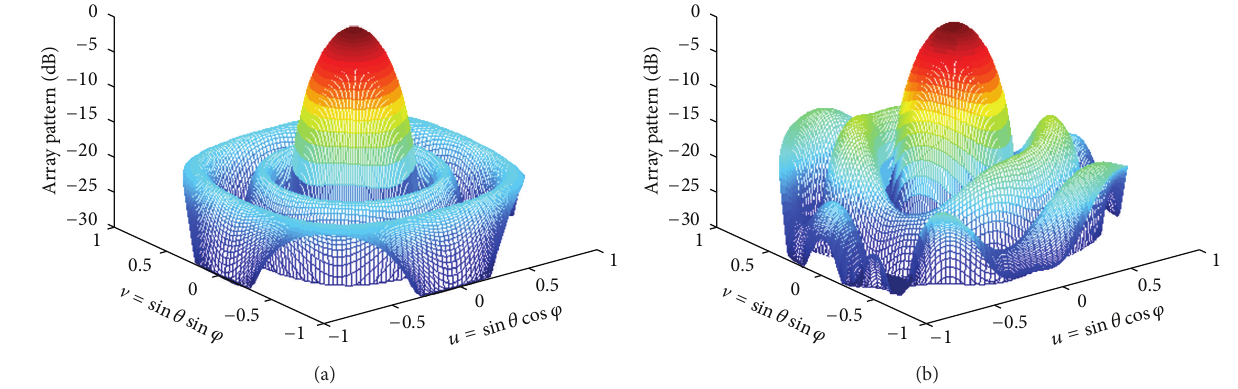
Figure 5: (a) The Chebyshev radiation pattern. (b) The reconstructed radiation